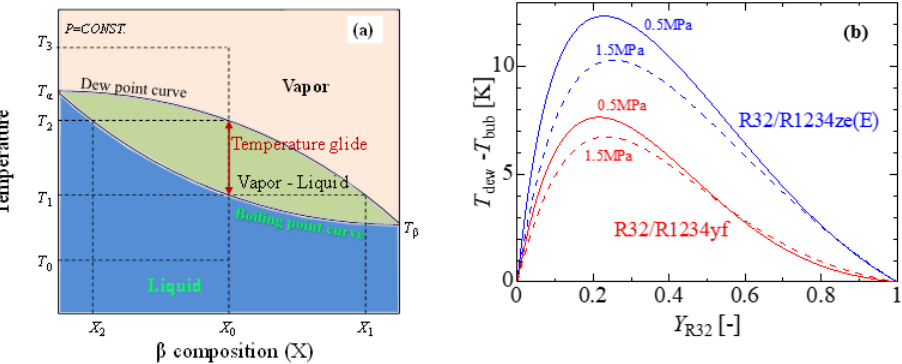
Figure 4. Temperature glides of a binary mixture. ( a ) Temperature vs. mass fraction diagram of a zeotropic mixture, ( b ) temperate glides of the R32/R1234ze € and R32/R1234yf binary blends.